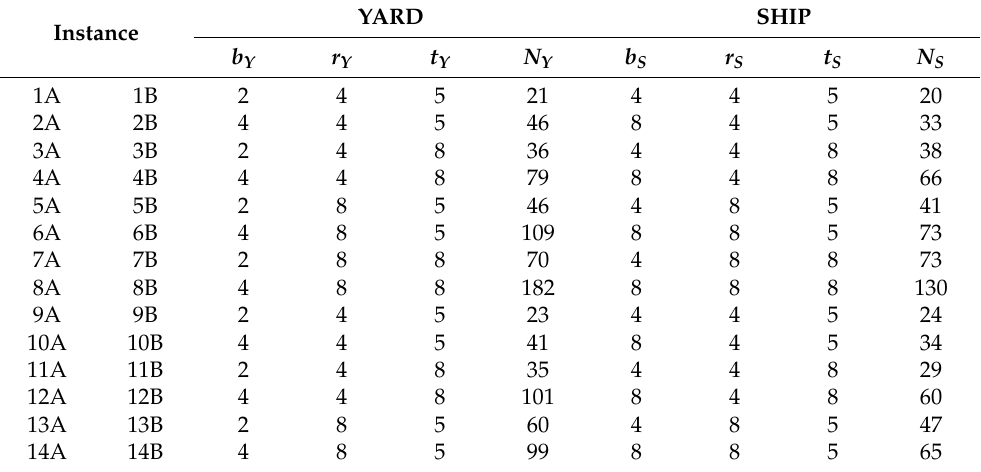
Table 3. Experimental